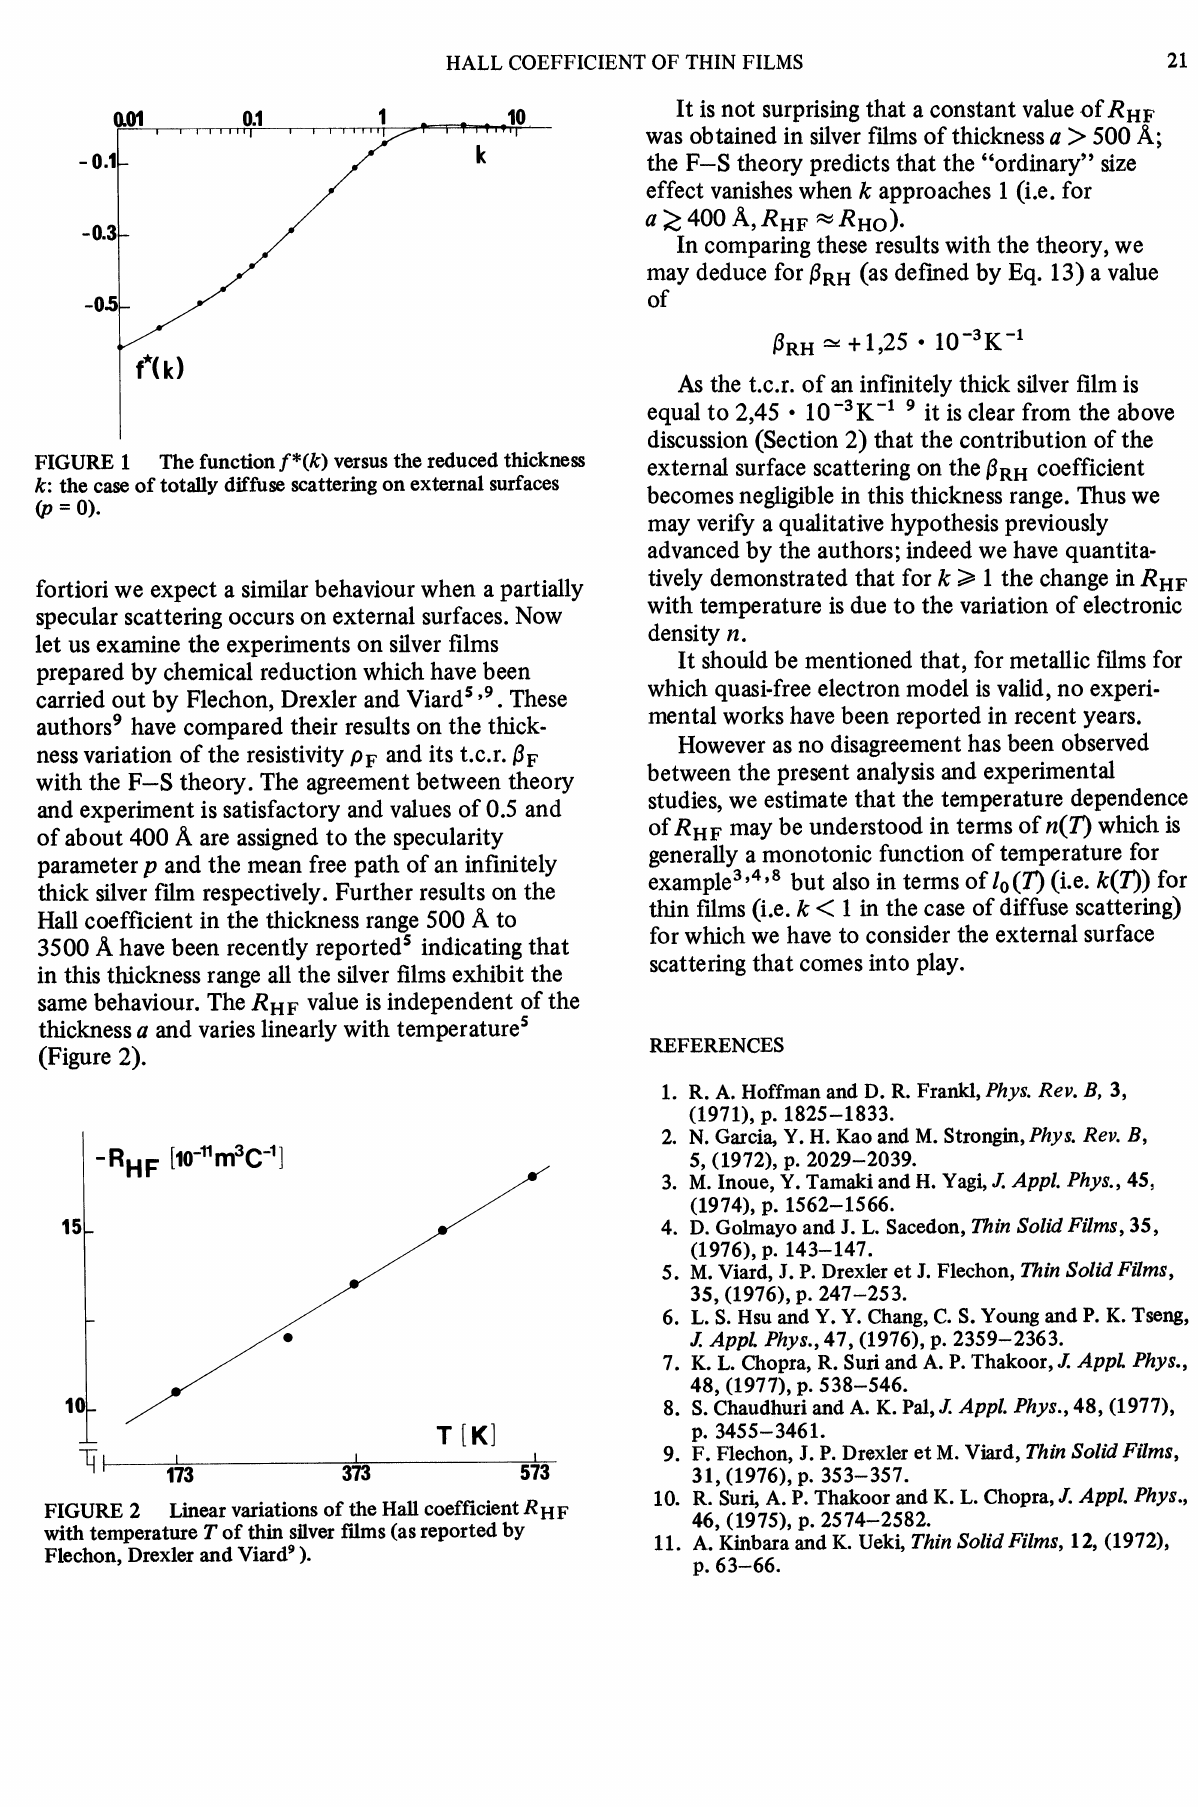
Linear variations of the Hall coefficient R H F with temperature T of thin silver films (as reported by Flechon, Drexler and Viard